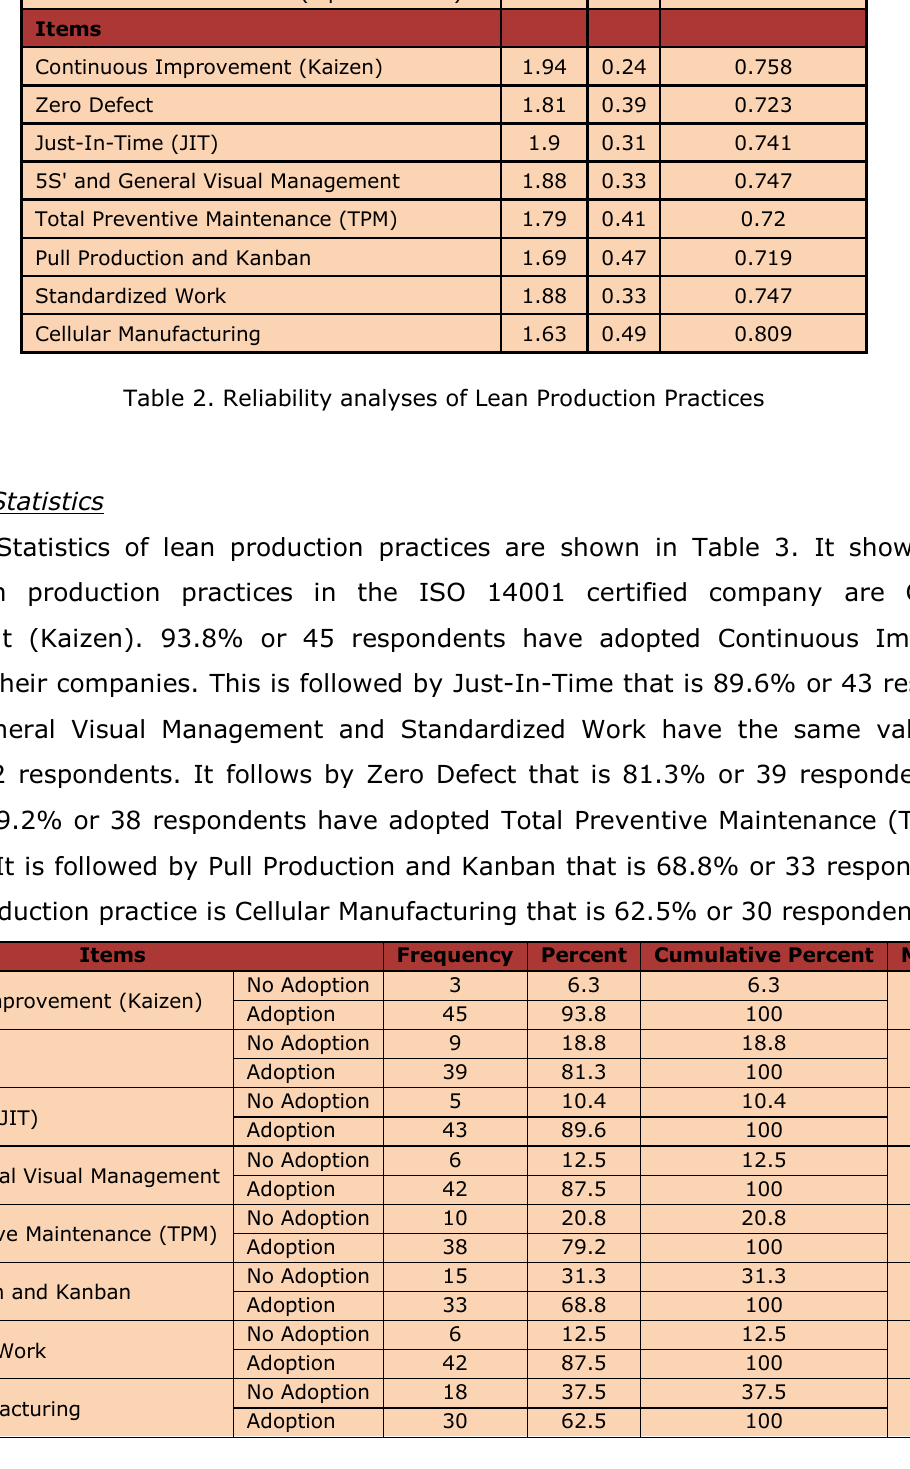
Table 3. Descriptive Statistics of Lean Production